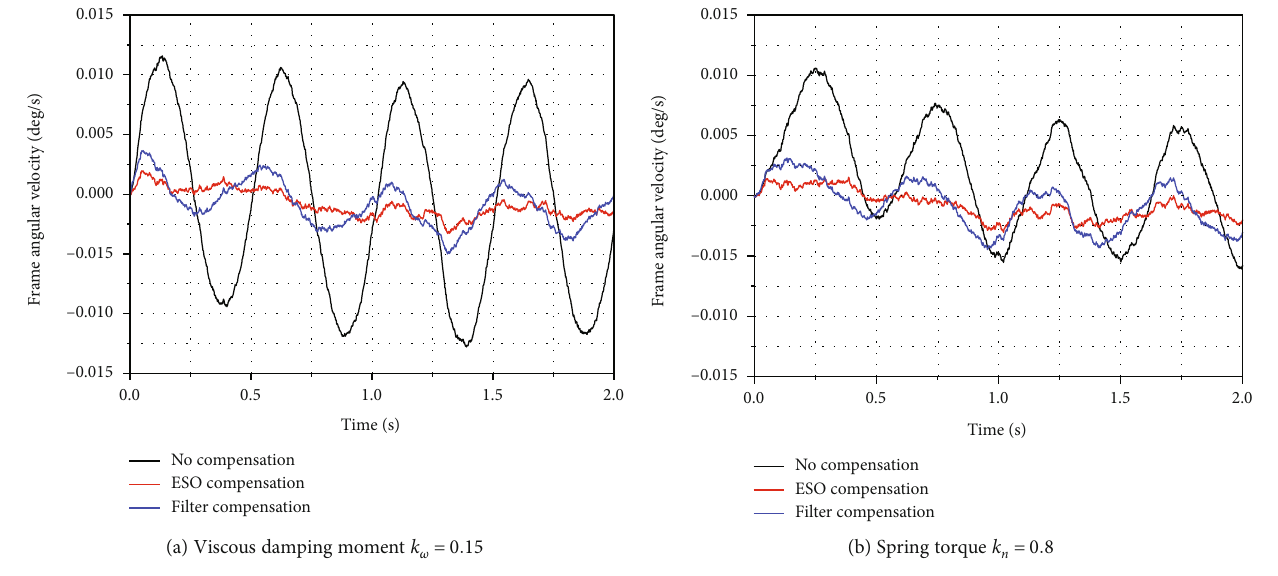
Figure 10: Angular velocity of the roll frame under interference torque after ESO